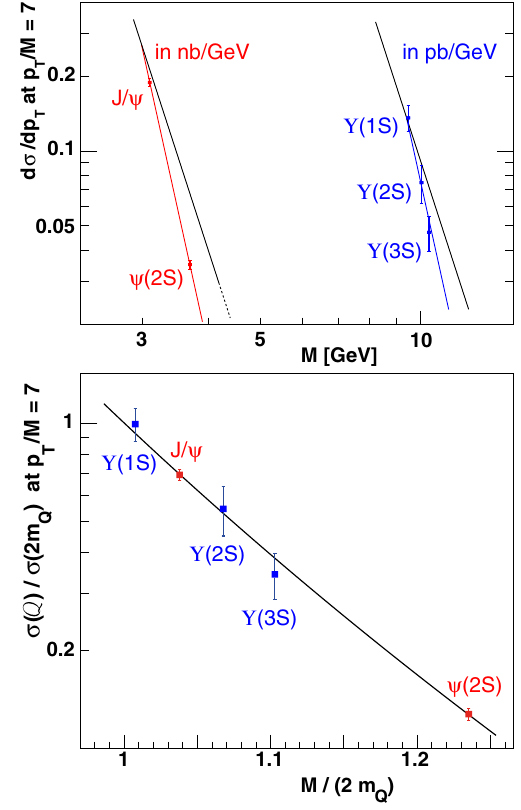
Fig. 4 Mid-rapidity direct production cross sections of 3 S 1 quarkonia, √ s = 7TeV and p T / M = 7. In the top panel, the (single) black line at is the result of a fit to the five cross sections, after extrapolating them (red and blue lines) to σ( 2 m Q ) . The bottom panel shows the common trend of the cross sections, normalized to the extrapolated values, for the five quarkonium states